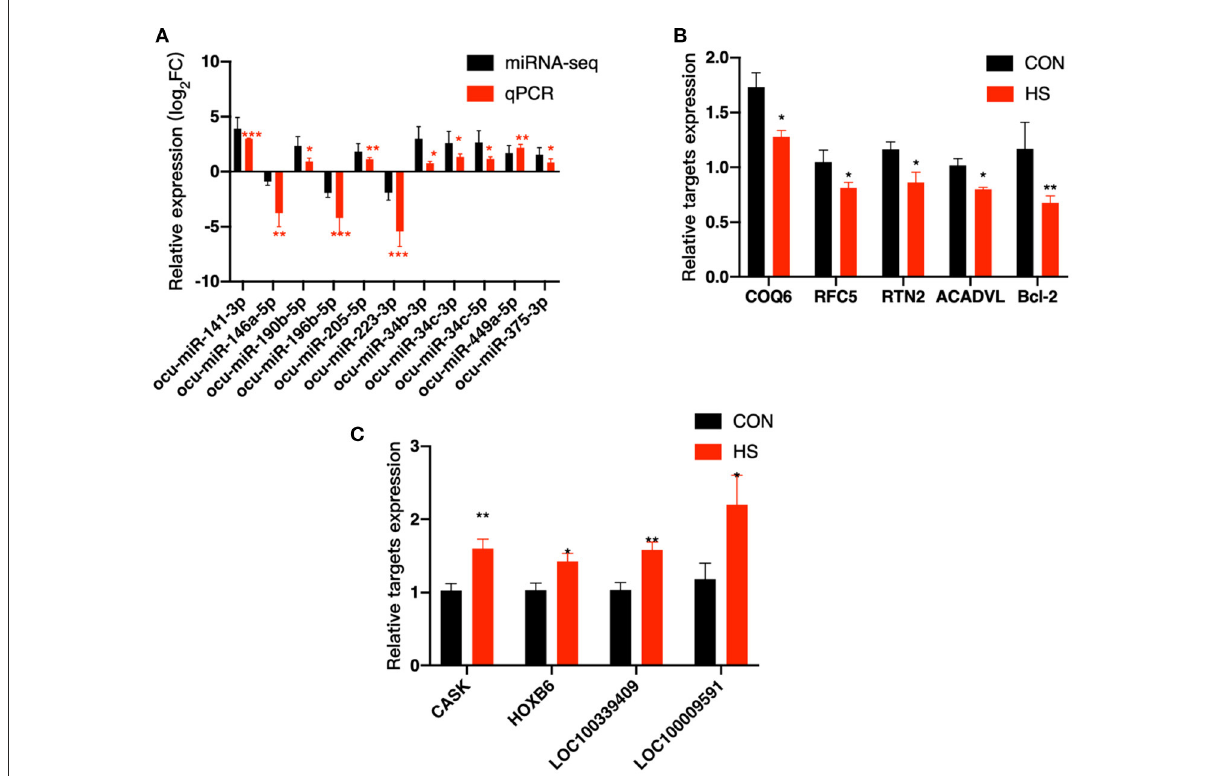
FIGURE5 Validation of DE miRNAs and their targets was done by qPCR. (A) Validation of 11 DE miRNAs; (B,C) Validation of potential targets. COQ6 , coenzyme Q6; monooxygenase; RFC5 , replication factor C subunit 5; RTN2 , reticulon 2; ACADVL , acyl-CoA dehydrogenase very long chain; Bcl-2 , B-cell CLL/lymphoma 2 protein; CASK , calcium/calmodulin dependent serine protein kinase; HOXB6 , homeobox B6; LOC100339409 , ATPase inhibitor; mitochondrial-like; LOC100009591 , sodium channel protein type 1 subunit alpha. * and ** indicated statistically significant